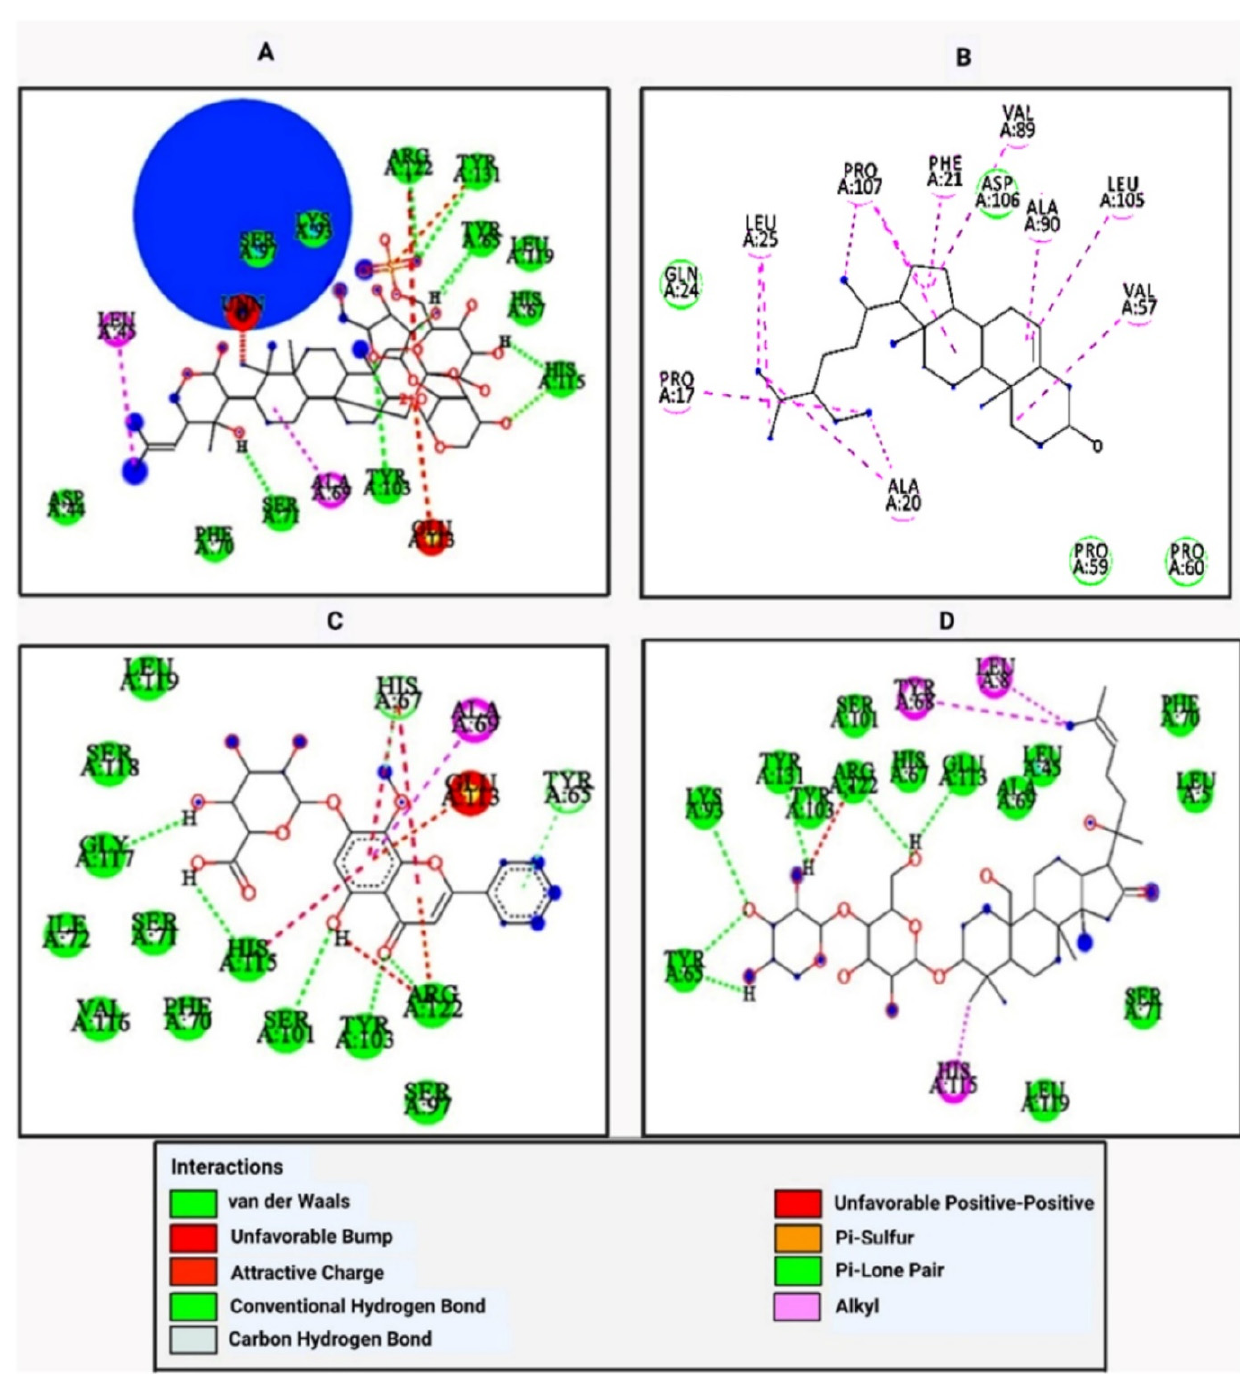
Figure 2. The 2D interactions of bioactive molecules of B. monnieri in complex with 5WEW: ( A ) Bacopaside I, ( B ) β -sitosterol, ( C ) Oroxindin, and ( D ) Bacoside A.